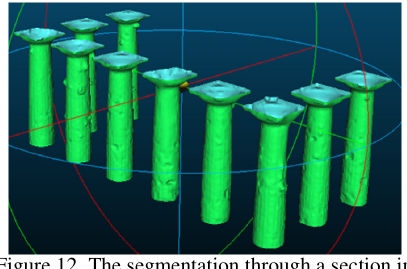
Figure 12. The segmentation through a section in CloudCompare.